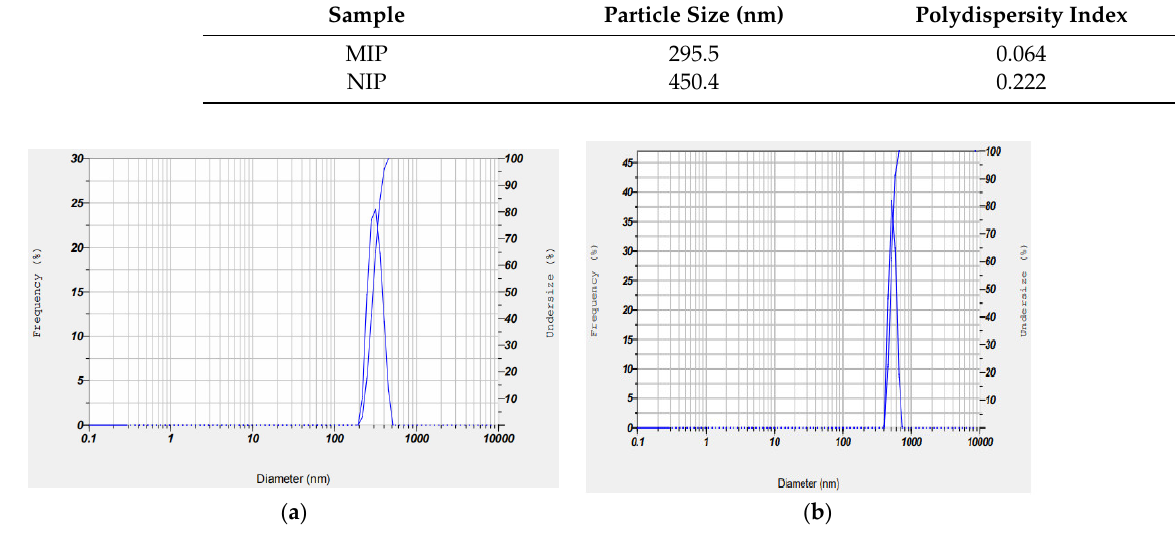
Figure 5. The size distribution curve of MIP ( a ) and NIP ( b ).